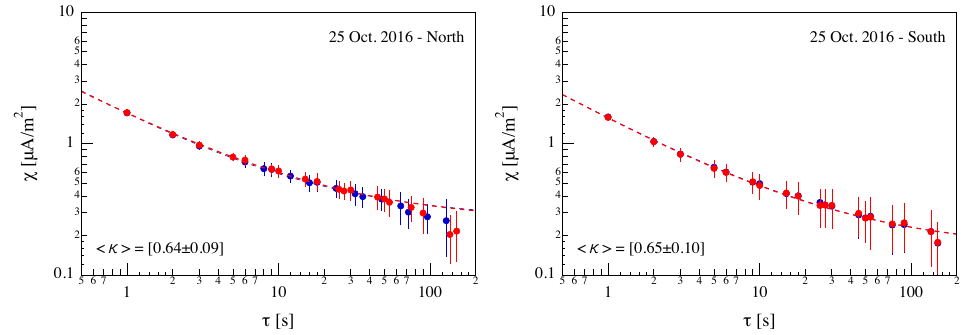
Figure 6. The partition function χ ( τ ) averaged on the Northern and Southern Hemisphere crossings of the polar ionosphere on 25 October 2016. Blue and red solid circles refer to Swarms A and C, respectively. The dashed lines are power-law fits of the form a 0 τ − κ + a 1